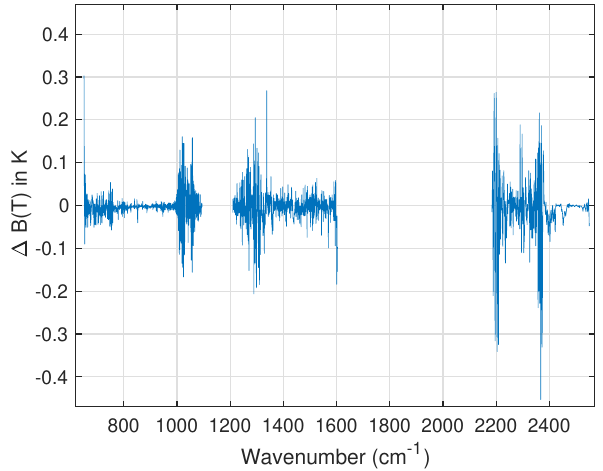
Figure 3. Example showing the magnitude of the statistical correction used in the AIRS to CHIRP translation, after deconvolution of AIRS and reconvolution to the CHIRP spectral resolution. The large ringing near 2200 cm − 1 is likely due to fringes in the AIRS spectral response functions that are not accurately accounted for in the AIRS to CrIS conversion.